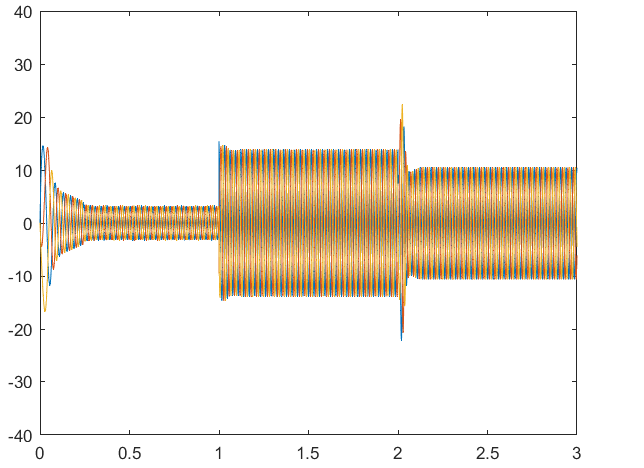
Figure 9. Stator currents under variation 100% of Rr.